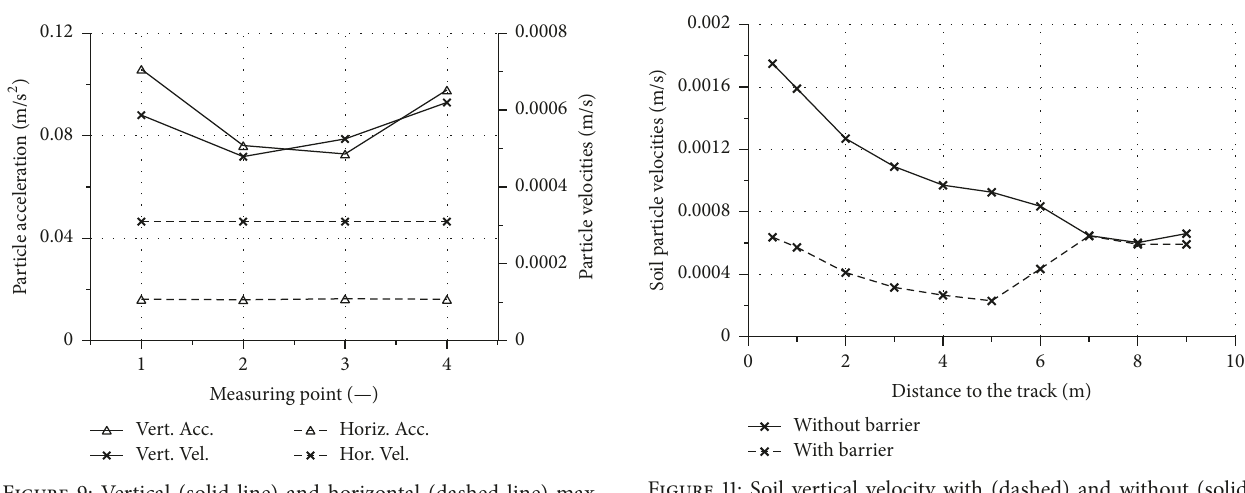
Figure 9: Vertical (solid line) and horizontal (dashed line) max- imum acceleration and velocities on four different points of the foundation slab.